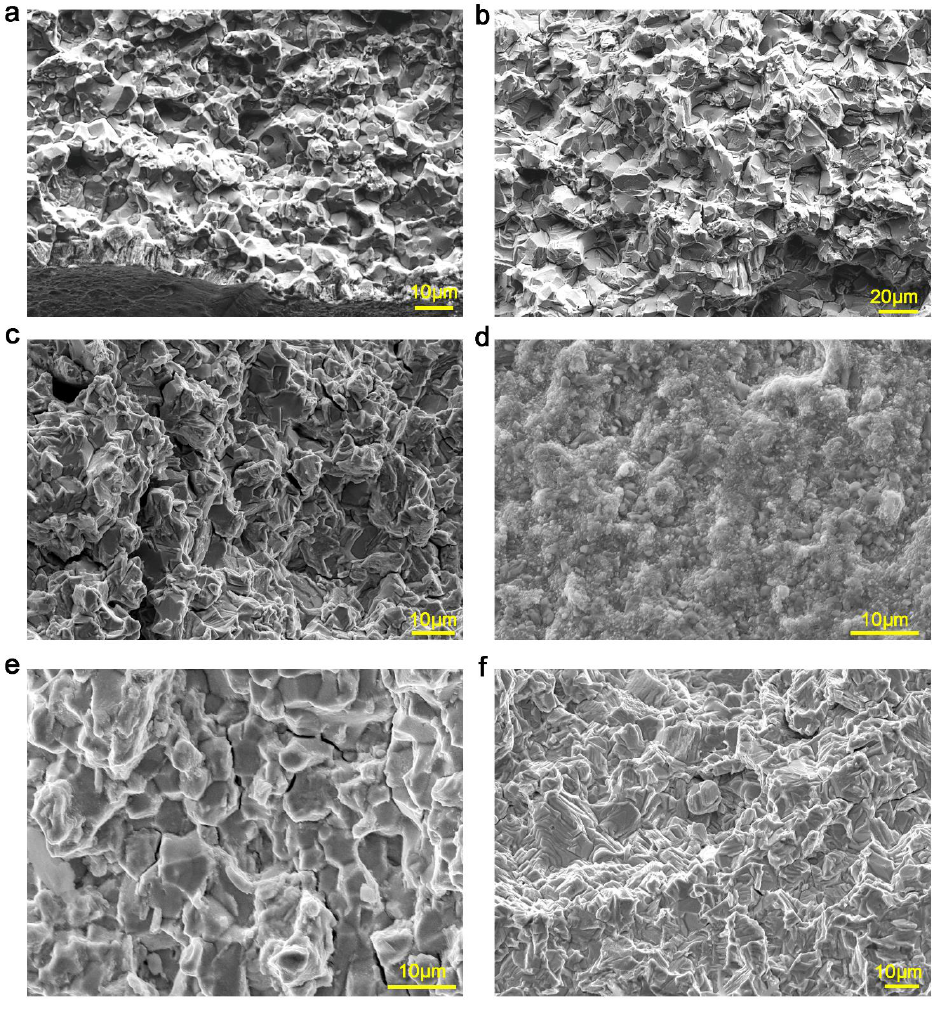
Figure 5. Fracture surface of fatigue cracks in 718Plus alloy with different hold-times. ( a – c ) 5 s hold-time; ( d – f ) 90 s hold-time; ( a , d ) initiation region; ( b , e ) propagation region; ( c , f ) rupture region